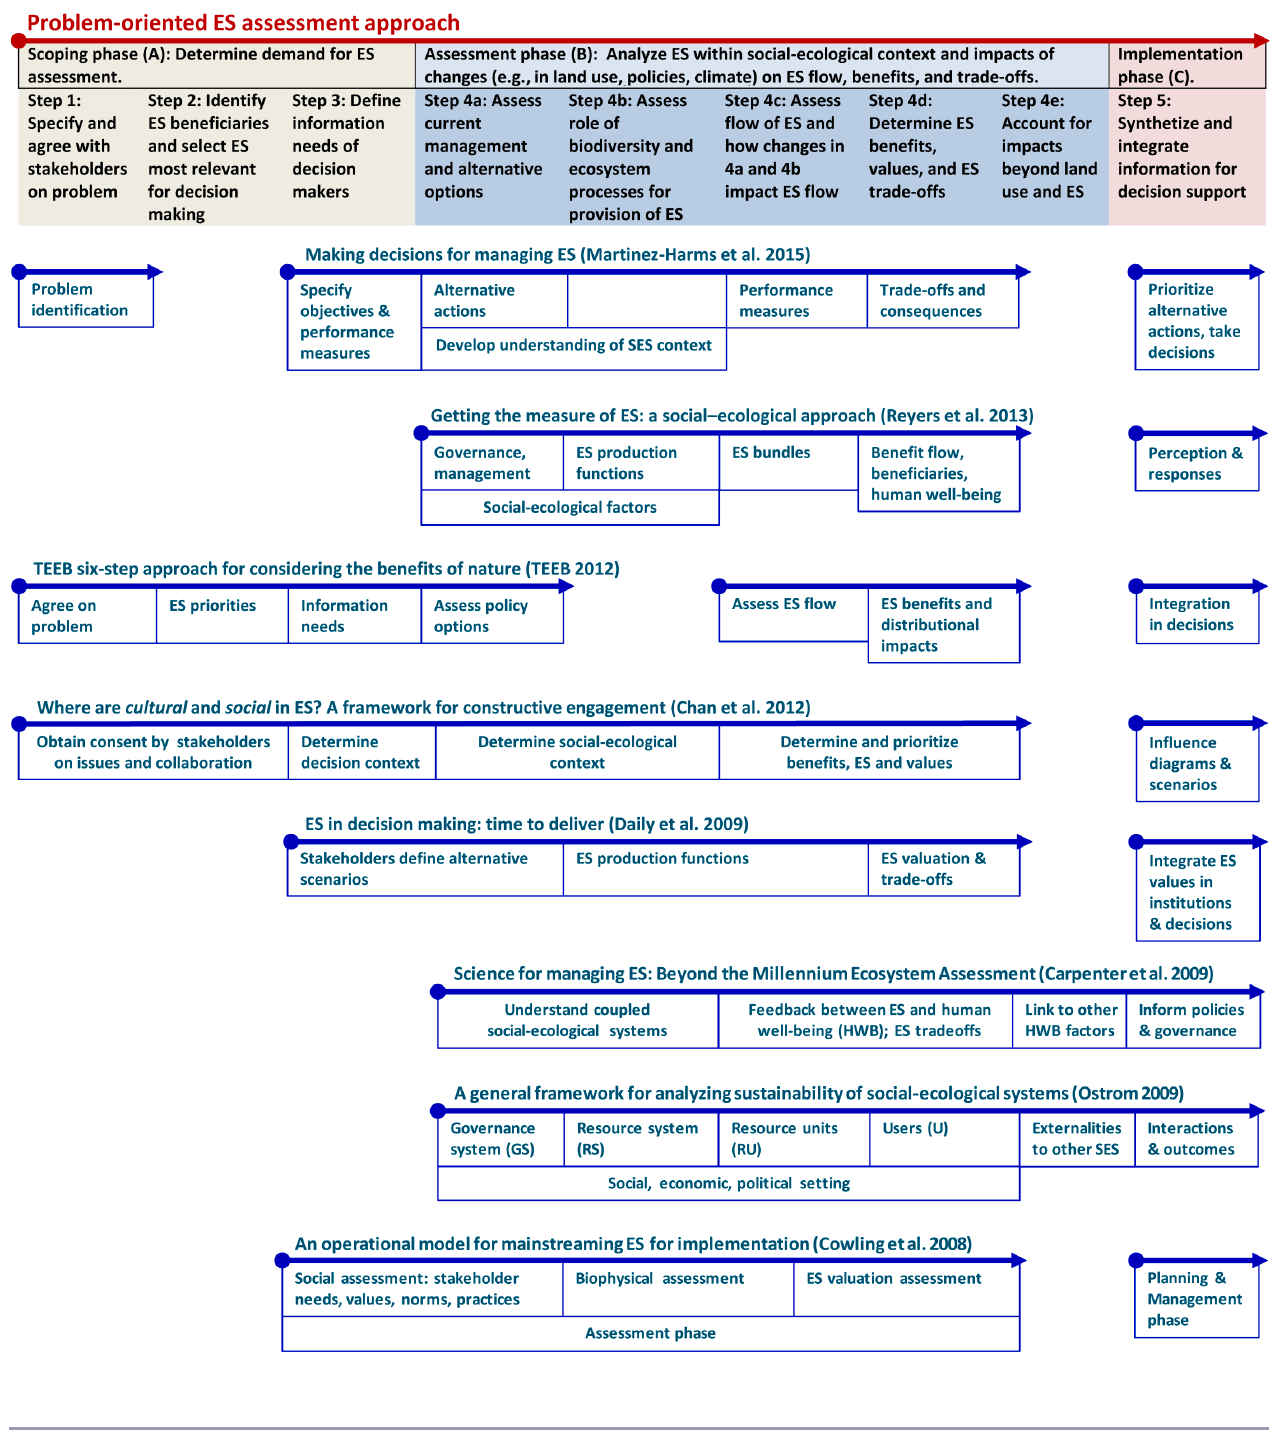
Fig. 2 . The problem-oriented approach for assessing ecosystem services (ES) of the Sustainable Land Management (SLM) Program (at top) compared with other approaches for assessing ES using a social-ecological systems (SES) perspective. Steps can be applied sequentially (arrows), interchangeably, and repetitively within iterative assessment